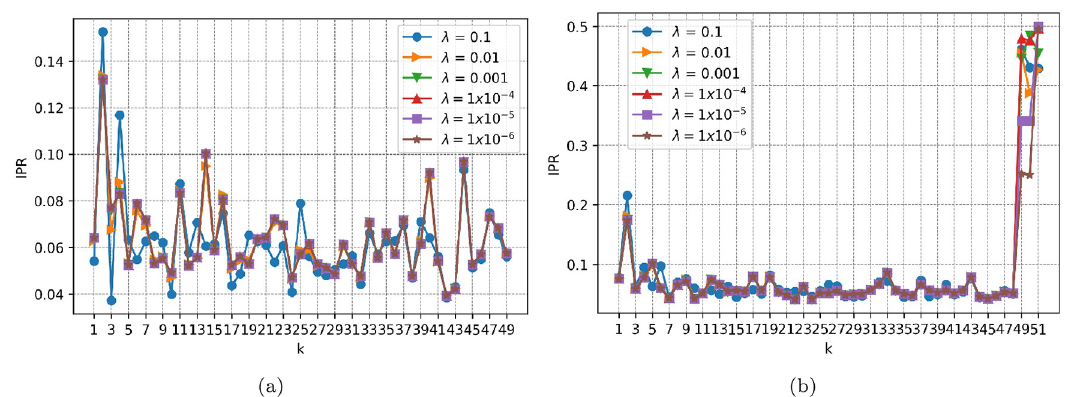
Fig 8. IPR. Inverse participation ratio for the entire sample period of time for various values of the regularization parameter λ . (a) Predictor factors. (b) Response factors.